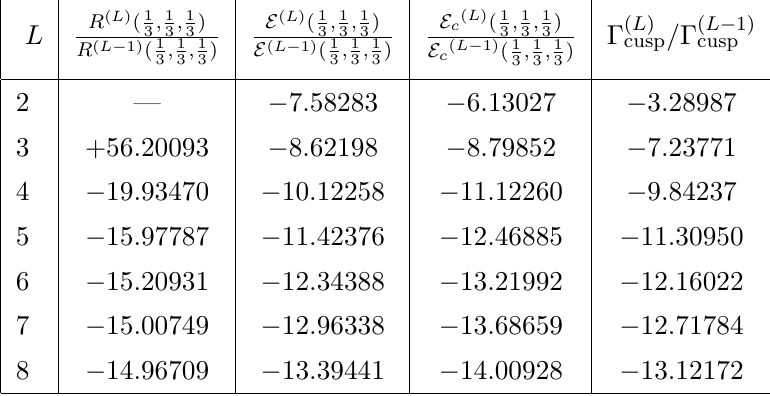
Table 8. The ratio of R , E , and E c at sequential loop orders, evaluated at the symmetric point ( u, v, w ) = ( 1 , 1 , 1 ) in the Euclidean region. We also give the ratio of the cusp anomalous dimension 3 3 3 at sequential loop orders for